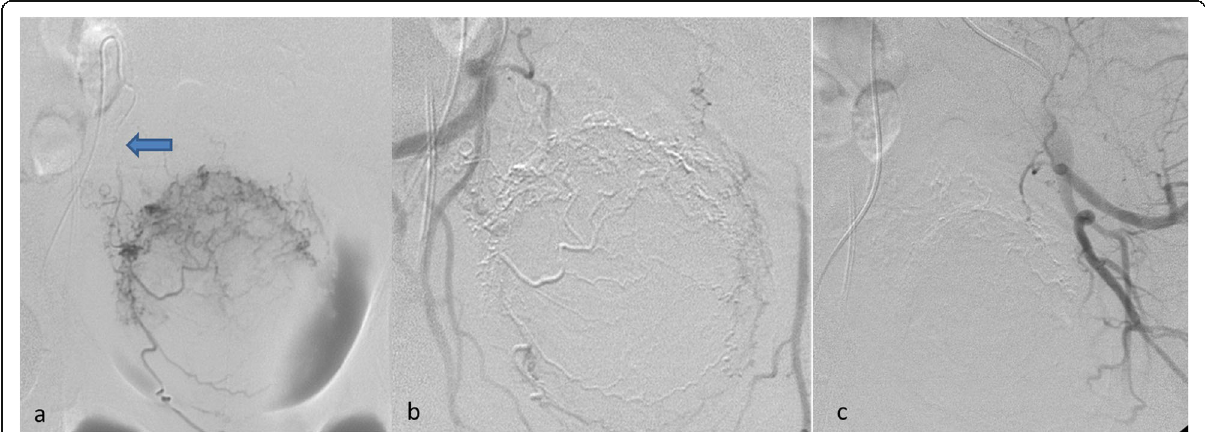
Fig. 2 Haemodynamically stable 84-year-old male patient suffering from with inoperable urinary bladder carcinoma and multiple episodes of haematuria not responding to conventional therapy. a Super-selective DSA with a micro-catheter within the right superior vesical artery (blue arrow) demonstrating pathologic vascularization of the bladder. b and c DSA following bilateral superior vesical artery glue embolization demonstrating complete devascularisation of the bladder. No bleeding relapse occurred